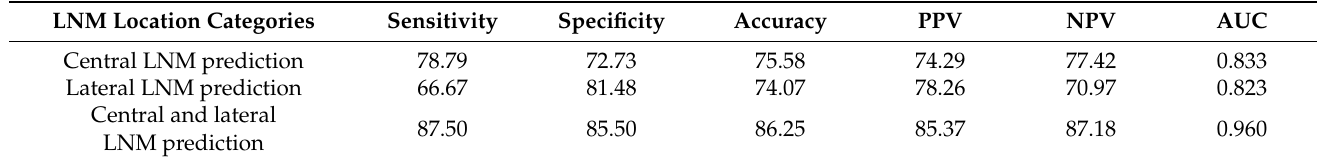
Table 5. Diagnostic performance of the combined model in different LN location